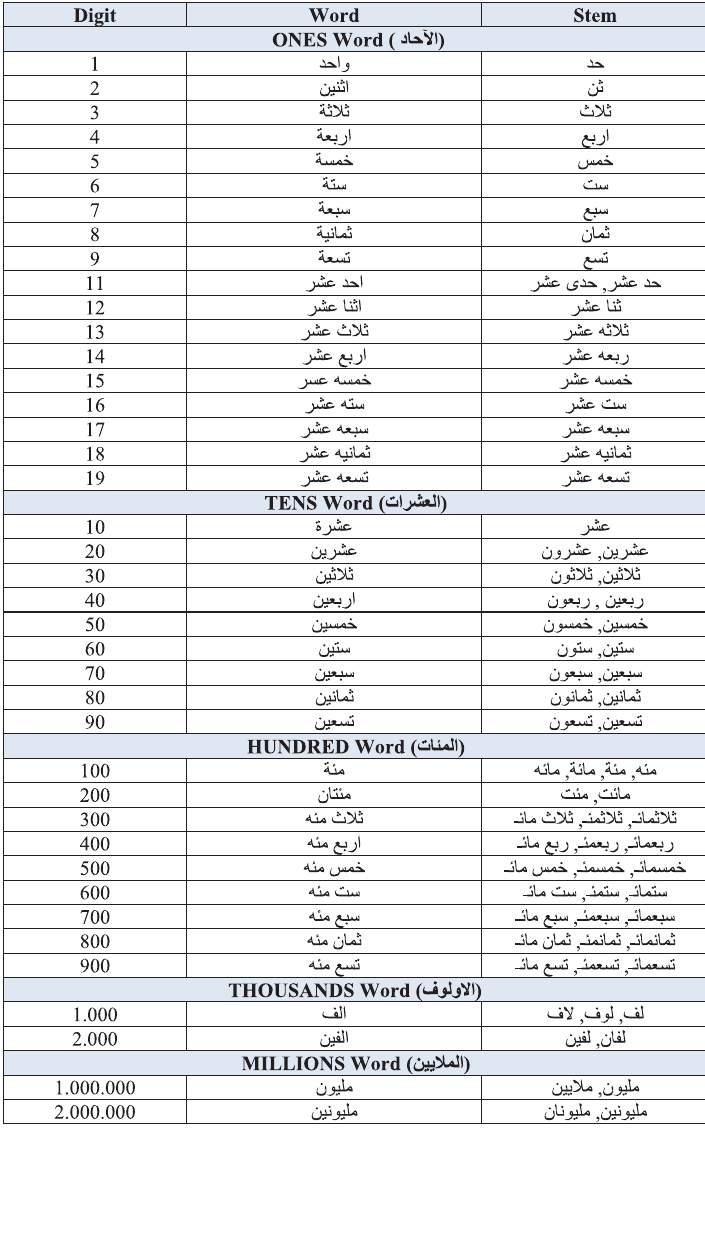
Table 1: Stems for Arabic